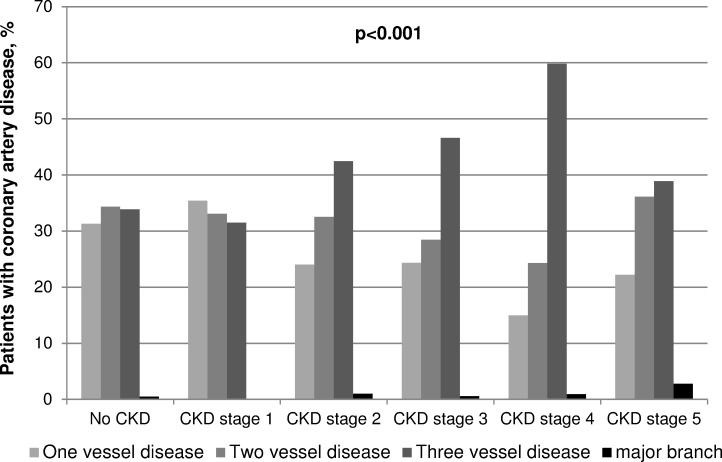
Proportions of patients with different degrees of CAD according to their renal function.P-values form Jonckheere-Terpstra tests.